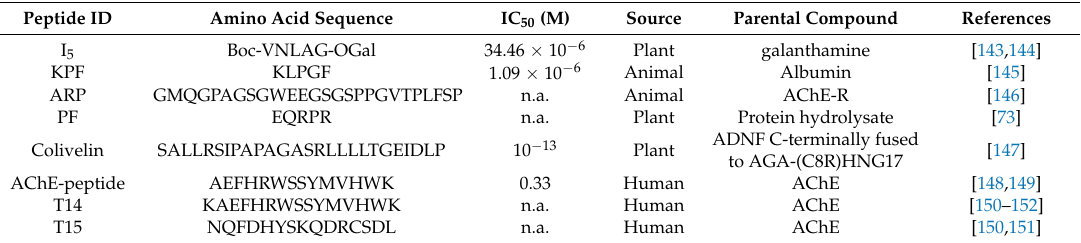
Table 1. Modified natural peptide analogs with activity against acetylcholinesterase of Alzheimer’s